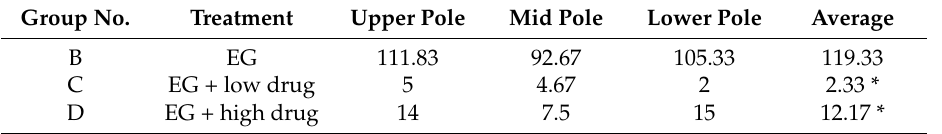
Table 4. Stone values of X-rats kidney tissue with ethylene glycol (EG) concentration. Group No. Table 5. Stone values of X-rats kidney section treated ethylene glycol (EG) and drug treatment. Group No.